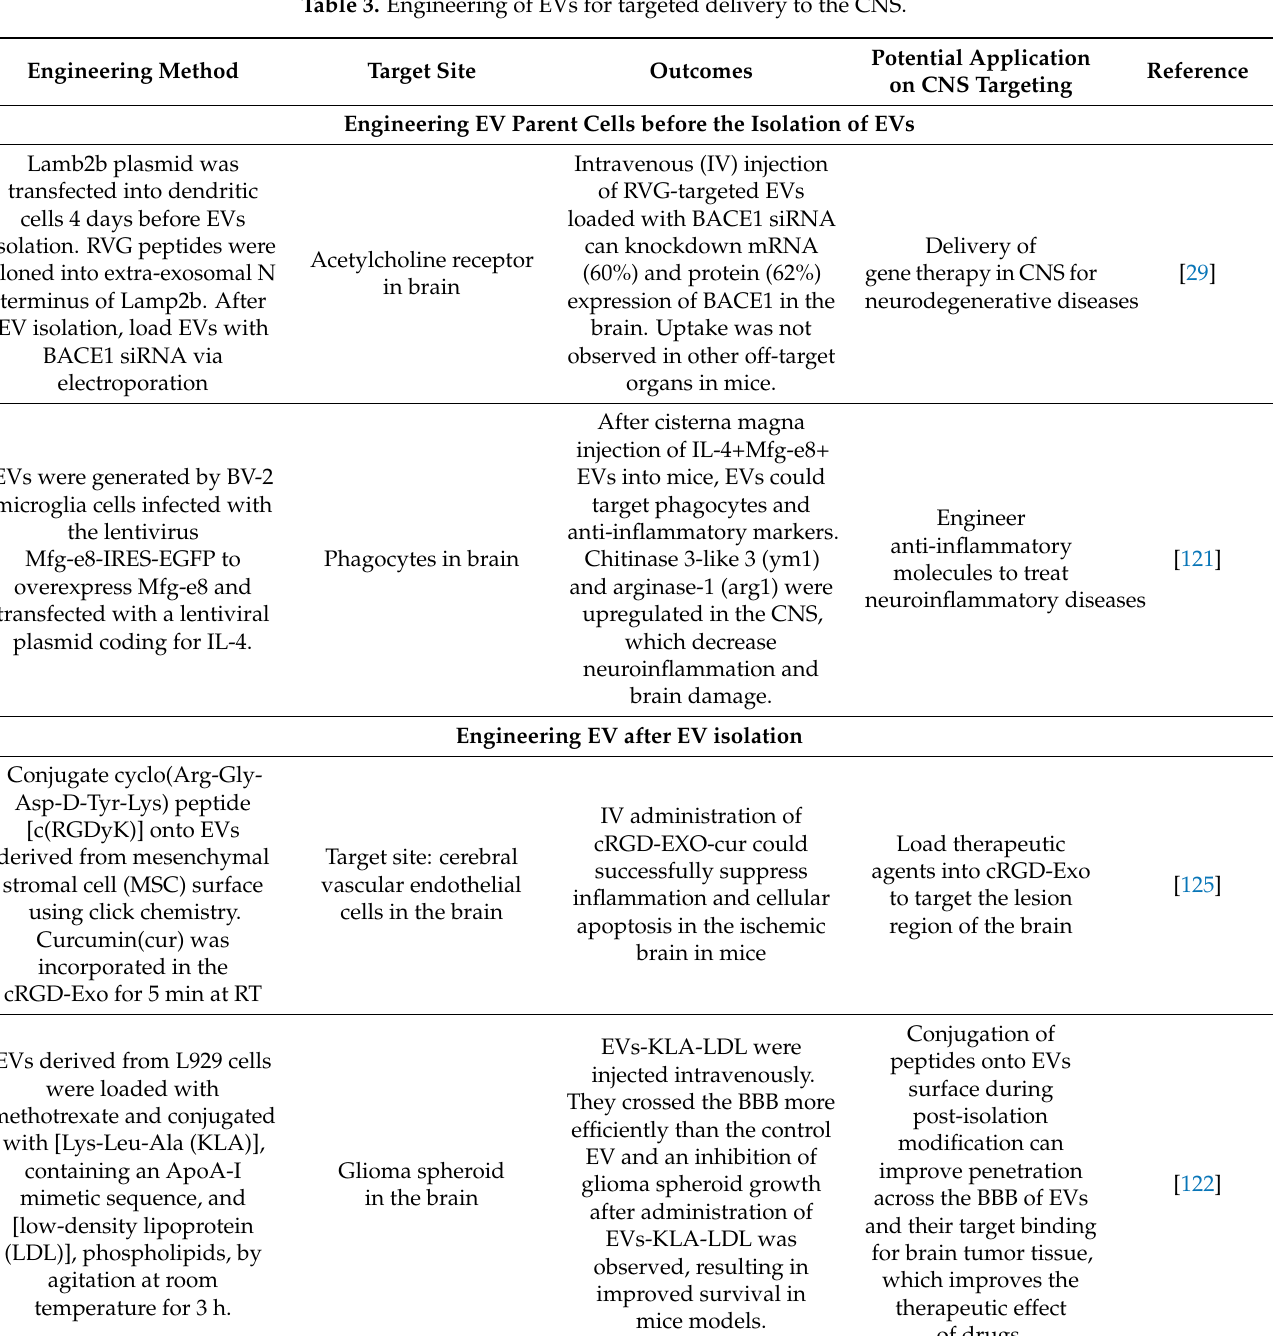
Table 3. Engineering of EVs for targeted delivery to the